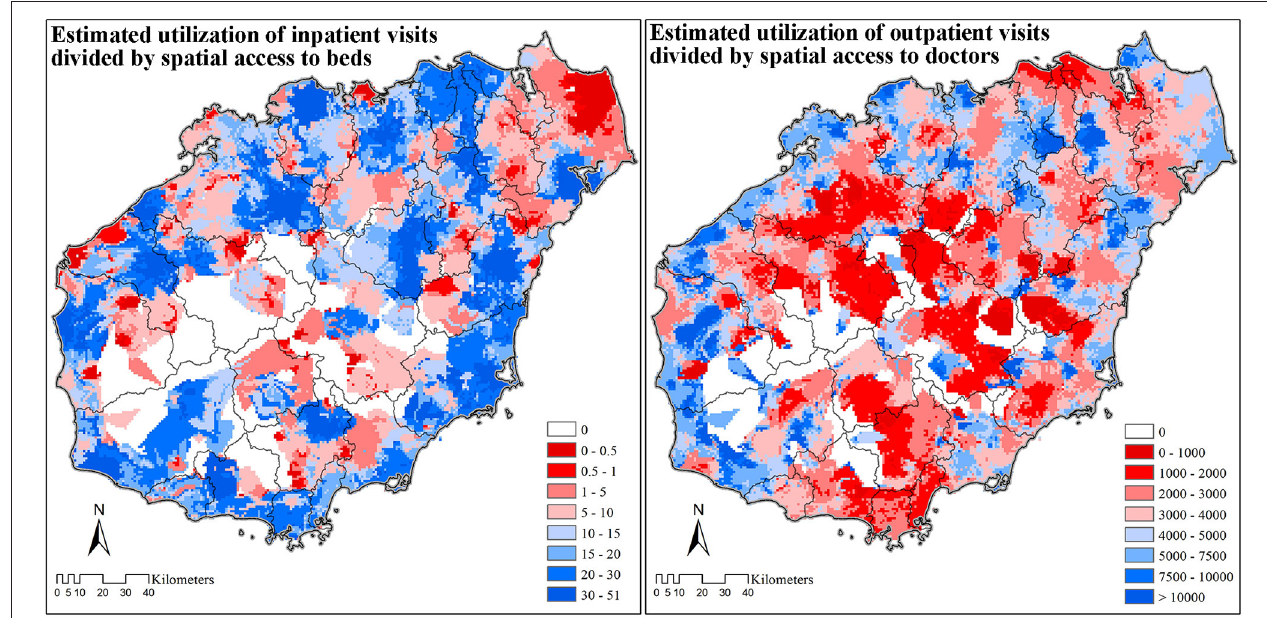
FIGURE 5 | The efficiency of healthcare resources on Hainan Island